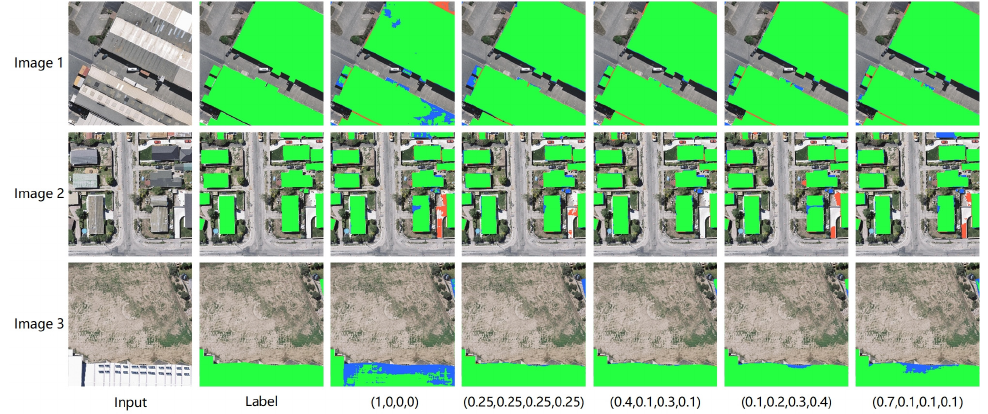
Figure 18. Typical building extraction results of BMFR-Net with different weight combinations of the multilevel joint constraint. In the graph, green represents TP, red represents FP, and blue represents FN.